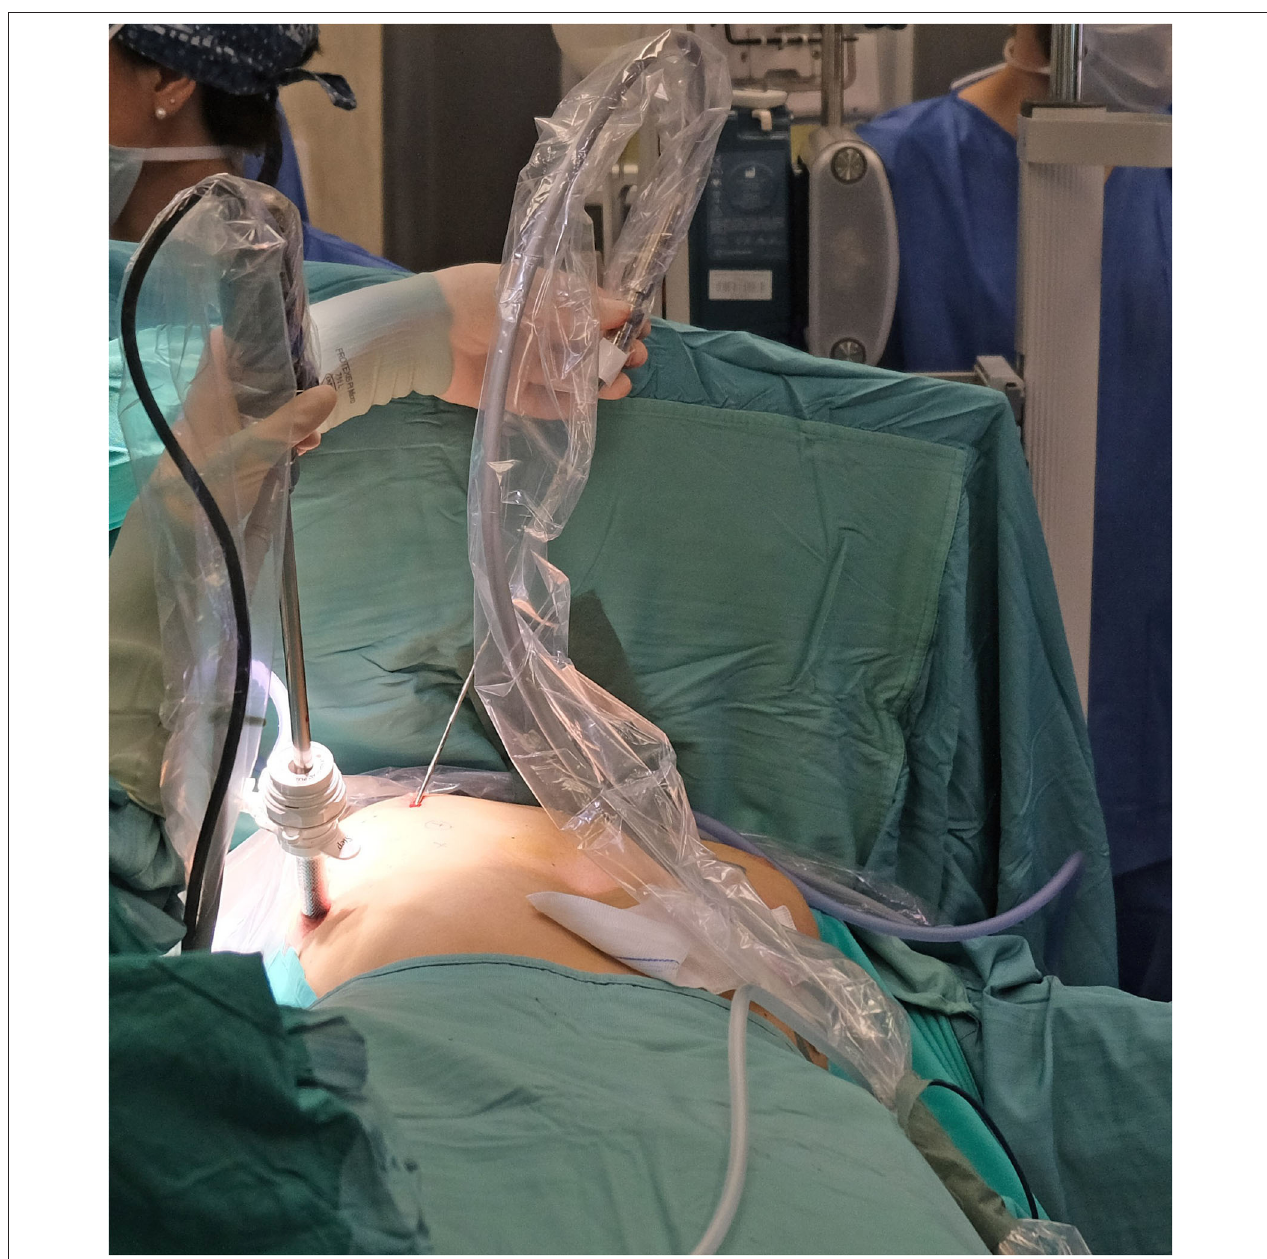
FIGURE 4 | Trocarless percutaneous probe insertion in a medial